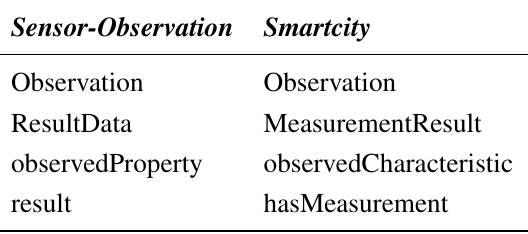
Table 6. Essential reference alignment for sensor-observation.